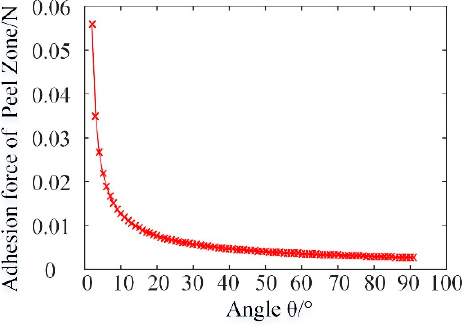
Figure 9. The adhesion force of the peel zone at different angles θ .